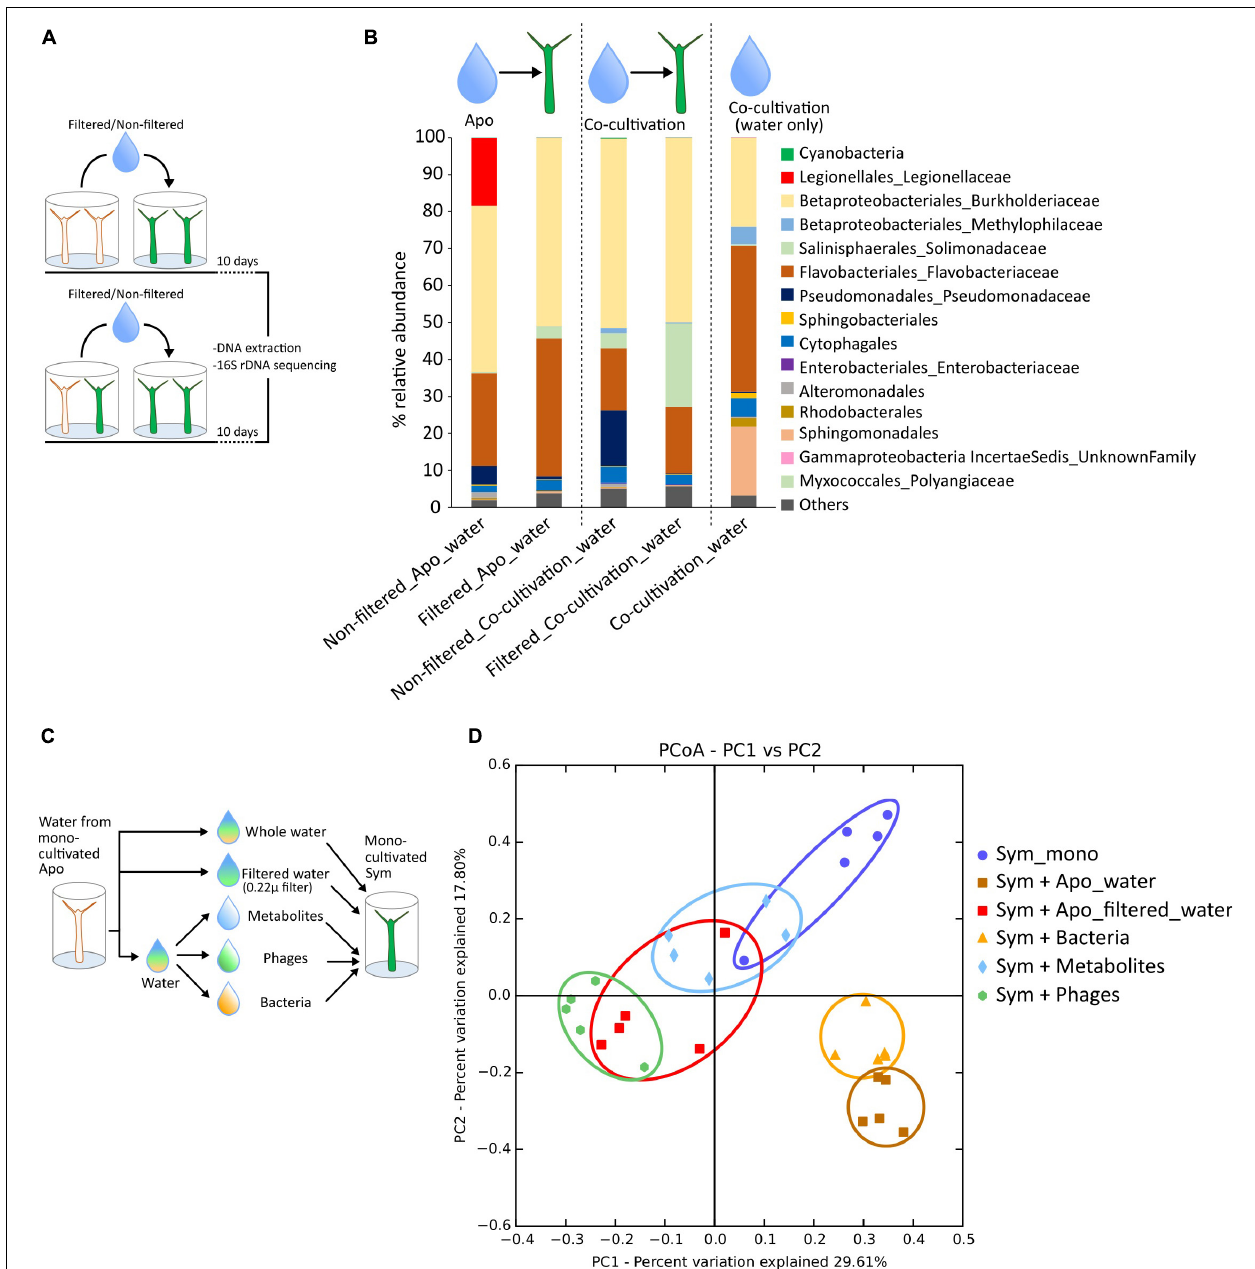
FIGURE 2 | Legionella is transferable through water. (A) Experimental setup to study the horizontal transfer of Legionella spp. Hvir . The mono-cultivated symbiotic animals were incubated in water from the aposymbiotic and co-cultivated animals for 10 days. The water filtered with 0.2 µ filter was used as control. (B) Taxa summary plots showing microbiome composition of the symbiotic animals treated with filtered/non-filtered water from aposymbiotic animals and co-cultivated animals along with microbiome composition of water of co-cultivated animals. (C) Experimental setup to study the effect of different fractions of water of aposymbiotic animals on the symbiotic animals. (D) Principal coordinate analysis (PCoA) plot constructed from Bray–Curtis dissimilarity matrix showing the microbiome composition of the symbiotic animals. The ellipses are manually drawn for visual